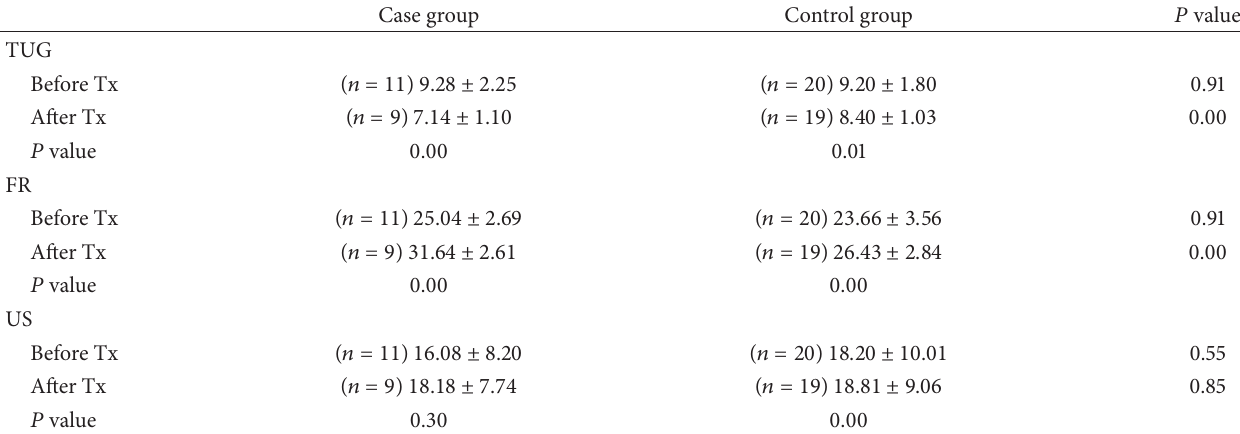
Table 2: Functional scores compared between two groups before and after